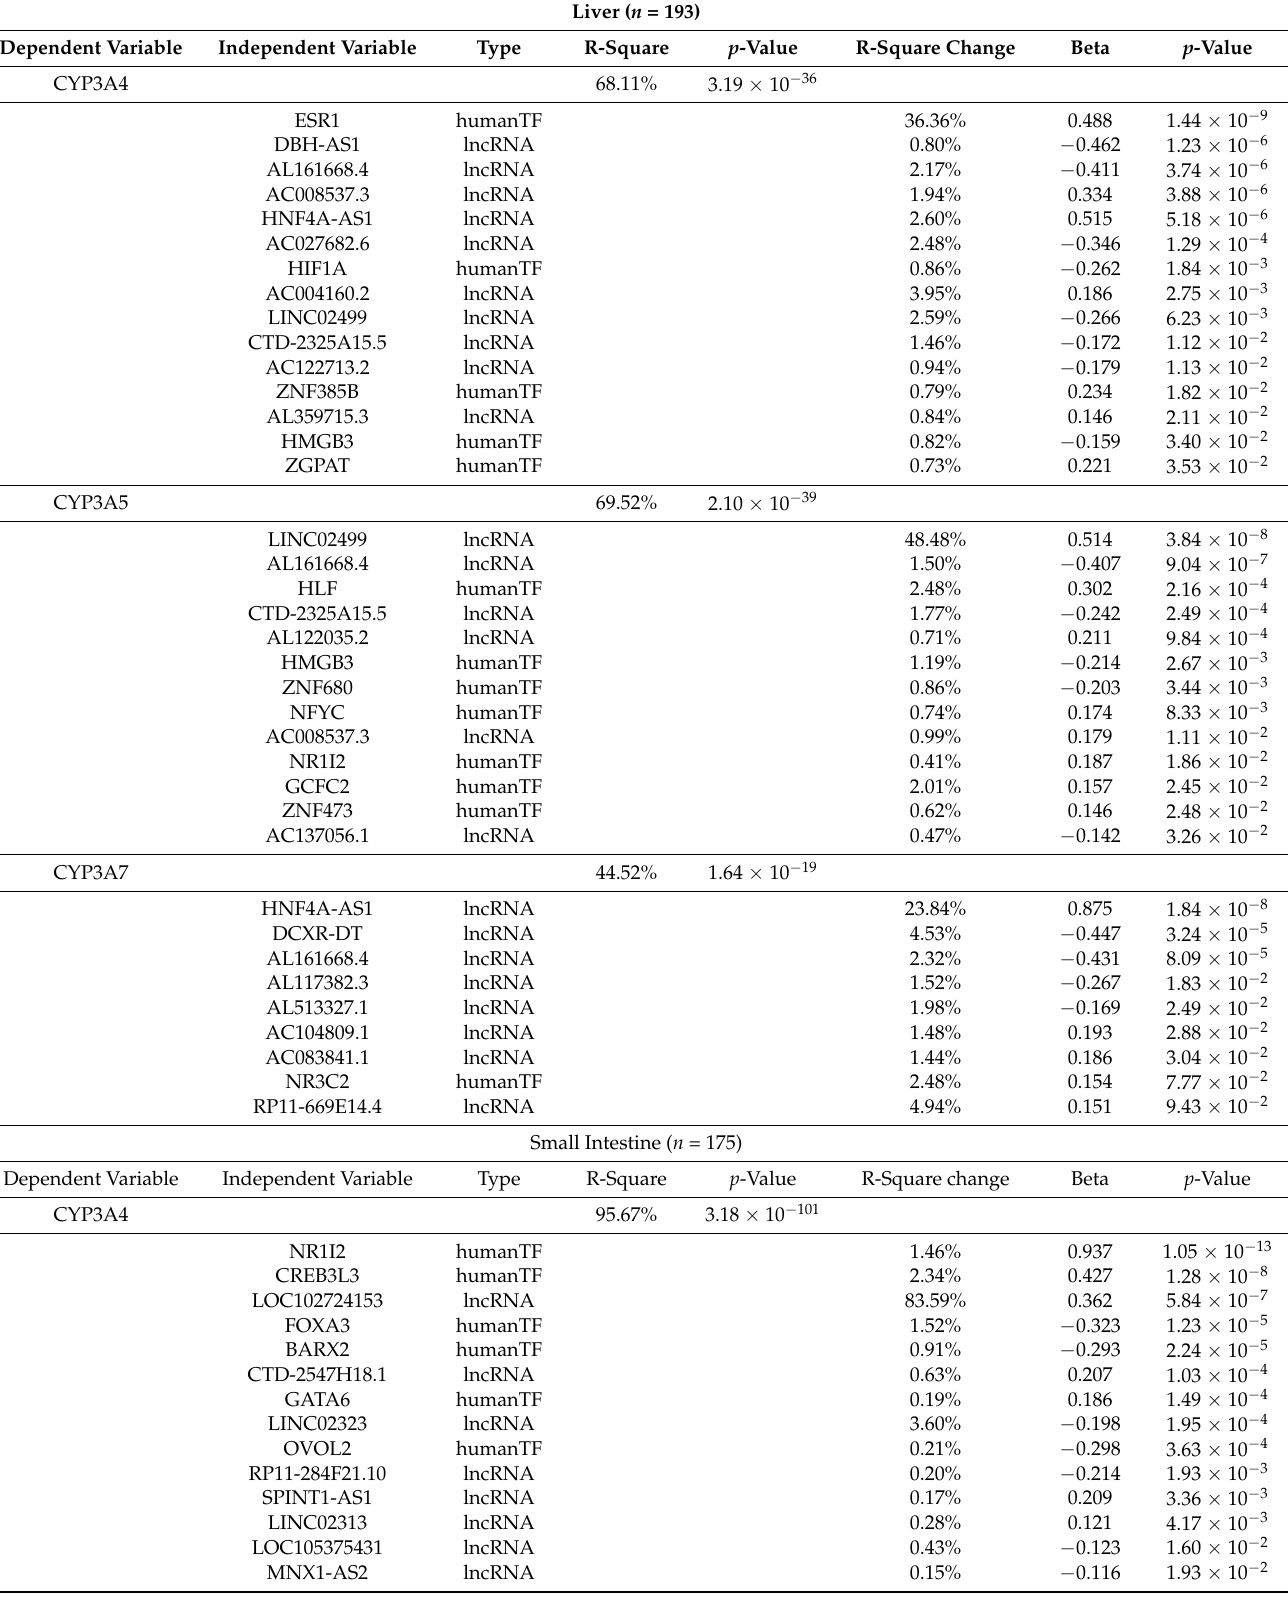
Table 3. Transcriptional factors and non-coding RNAs contributing to CYP3A expression in the liver and the small